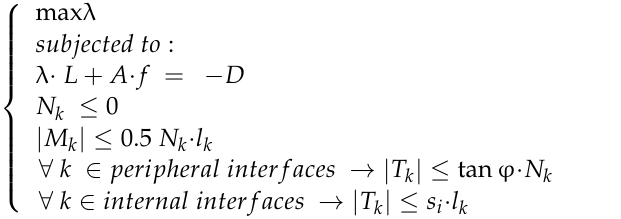
Table 2. Results obtained by Equation (8) and Stockdale et al. [64] for the simple example of Figure 11 when all the interfaces are peripheral.